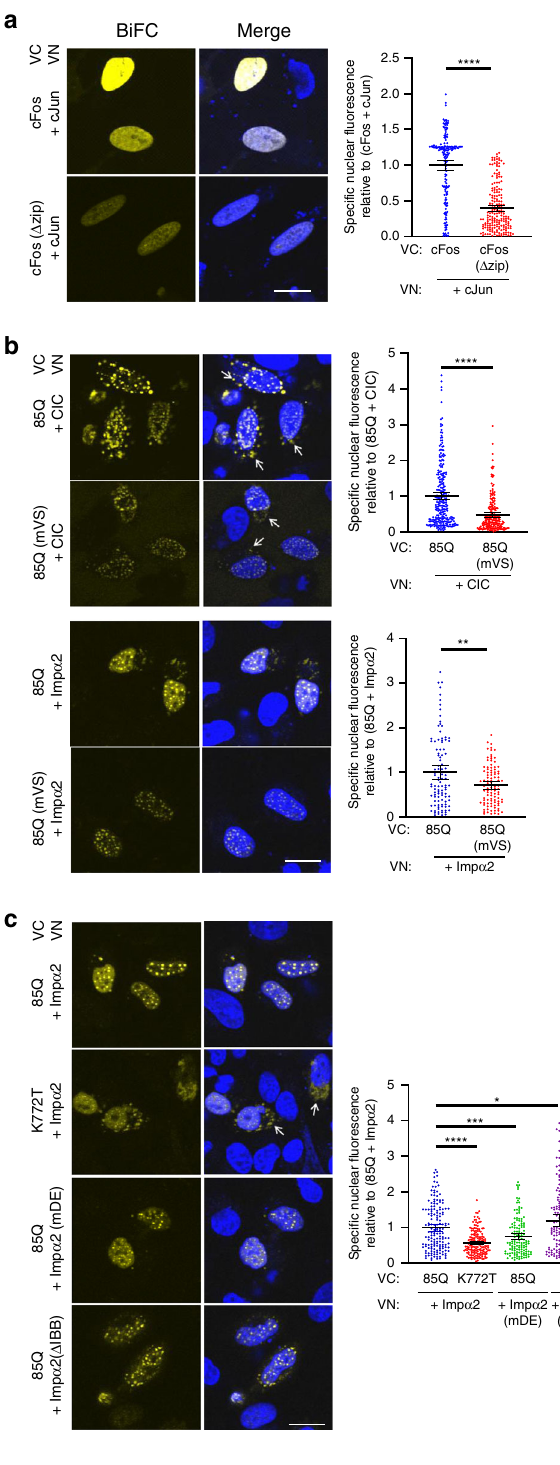
(Supplementary Fig. 5b – d), emphasising the importance of relationships of ataxin-1 with nuclear transport and/or nuclear transporters. In the BiFC system, the ataxin-1[85Q]K772T + importin- α 2 pair showed distinctive cytoplasmic bodies, but also with lower nuclear fl uorescence (Fig. 2c). Whilst this may suggest a contribution to binding via an NLS-dependent mechanism, the different nuclear/cytoplasmic localisation of ataxin-1[85Q]K772T complicates interpretation. Thus, we chose to evaluate the mechanism(s) of interaction with two importin- α 2 mutants, namely the importin- α 2 NLS-binding de fi cient mutant 43 (impor- tin- α 2 D192K/E396R, abbreviated herein as importin- α 2 mDE) and an importin- α 2 mutant for which the importin- β -binding domain within its N-terminus was removed 44 (importin- α 2 with residues 70-529 deleted, abbreviated herein as importin- α 2 ( Δ IBB)). Whereas nuclear fl uorescence was signi fi cantly reduced for the ataxin-1[85Q] + importin- α 2 D192K/E396R pair, a signi fi cant increase was noted for the ataxin-1[85Q] + impor- tin- α 2 Δ IBB pair. Thus, these analyses reinforce our proteomic identi fi cation of importin- α 2 as an interacting partner for ataxin- 1[85Q], with this interaction dependent on multiple domains of importin- α 2 and at least partially dependent on the ataxin-1 NLS as shown by the importin- α 2 mutants, but with some interaction remaining for the ataxin-1 NLS mutant. Collectively, these results reinforce a canonical relationship between a nuclear-localised protein such as ataxin-1 and nuclear transporters, and prompted us to question whether this relationship may be more complex with a potential impact of polyQ-ataxin-1 on nuclear transport processes as a mechanism contributing to SCA1.